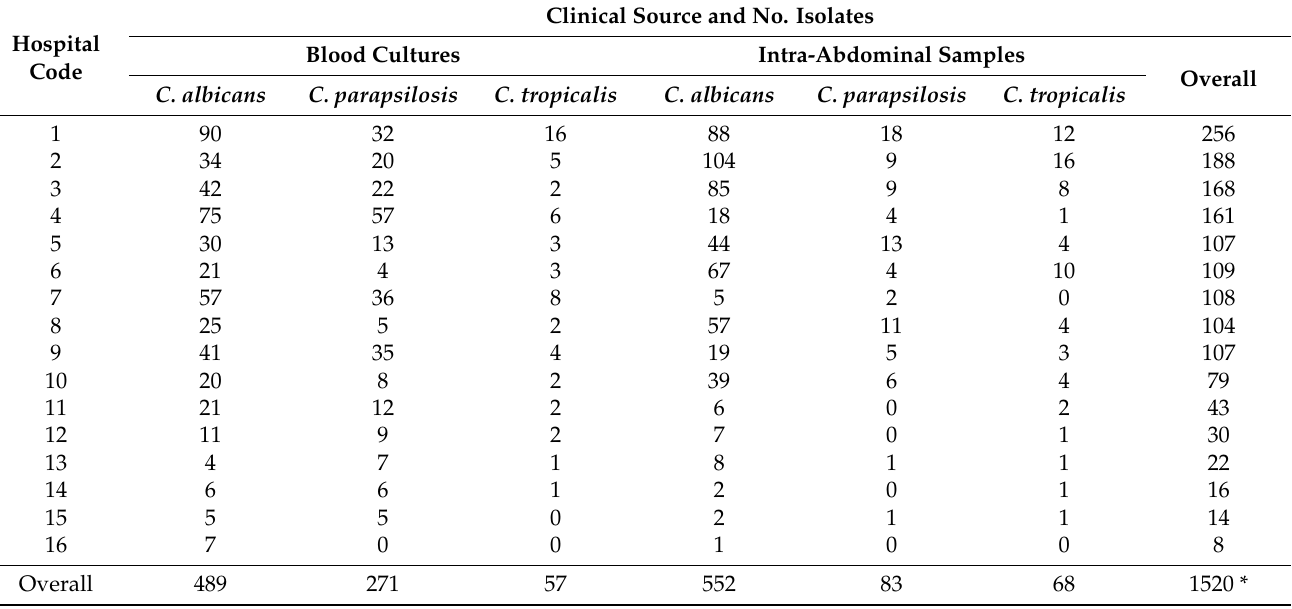
Table 1. Number of isolates studied (per species and source) collected during the CANDIMAD study at each of the 16 participant